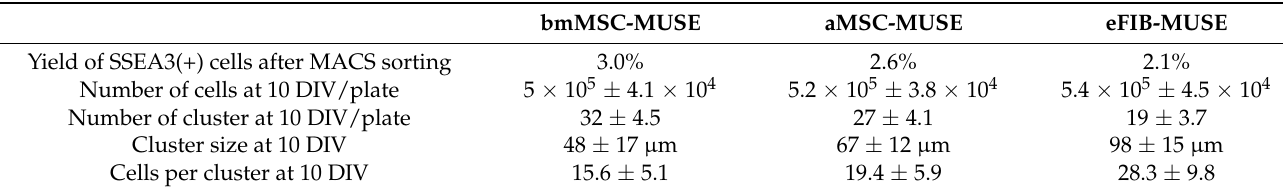
Table 1. Isolated cell population